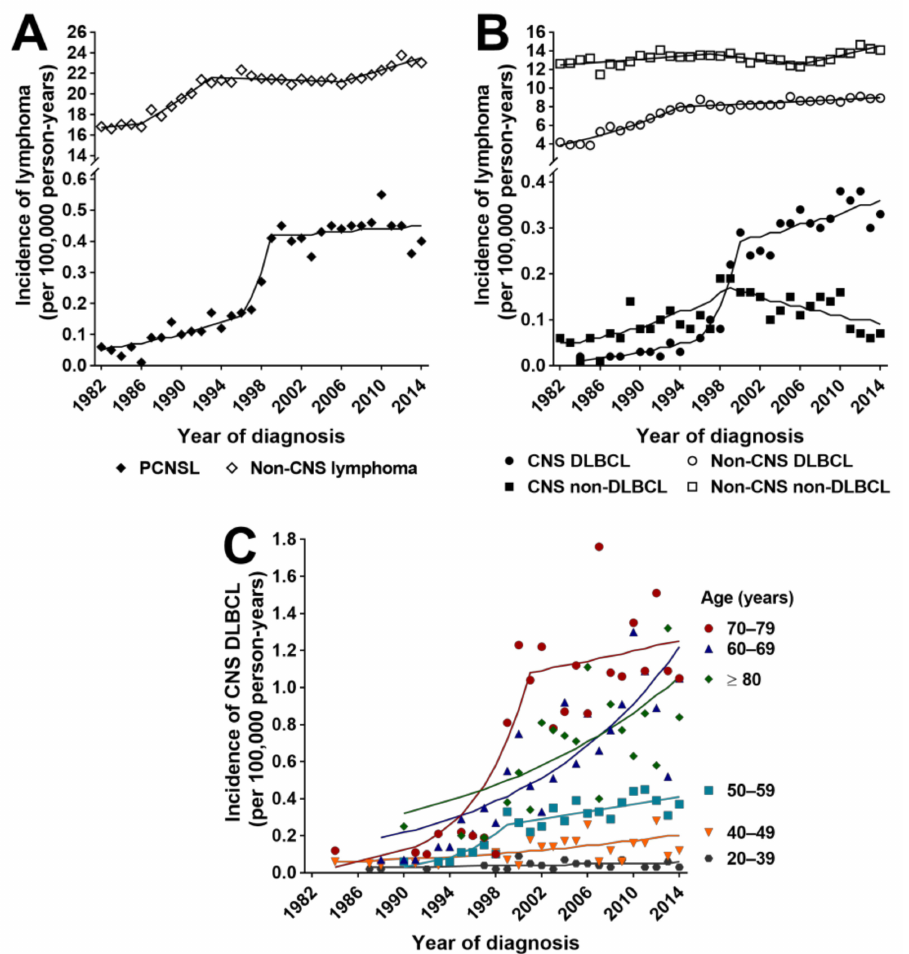
Figure 1. Age-standardized incidence rates over time for Australian adults with ( A ) primary central nervous system lymphoma (PCNSL) and non-CNS lymphoma; ( B ) diffuse large B-cell lymphoma (DLBCL) and other lymphomas (non-DLBCL) within the CNS and non-CNS compartments; ( C ) CNS DLBCL, presented by age group at diagnosis. Shapes indicate observed incidence rates, and continuous lines indicate modeled incidence